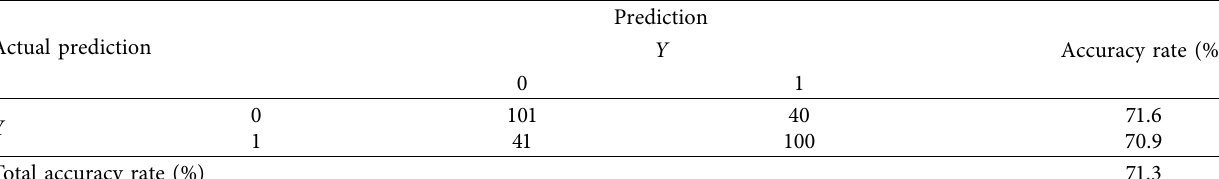
Table 2: Prediction